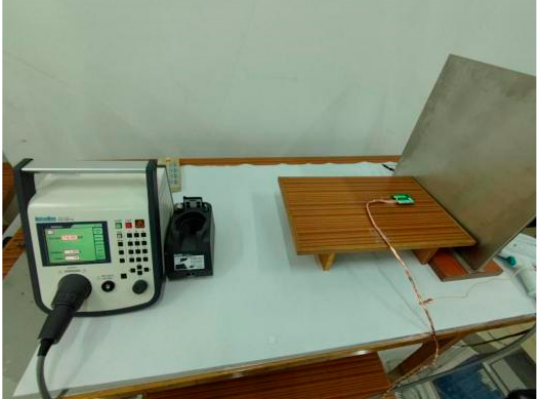
Figure 7. ESD simulator.